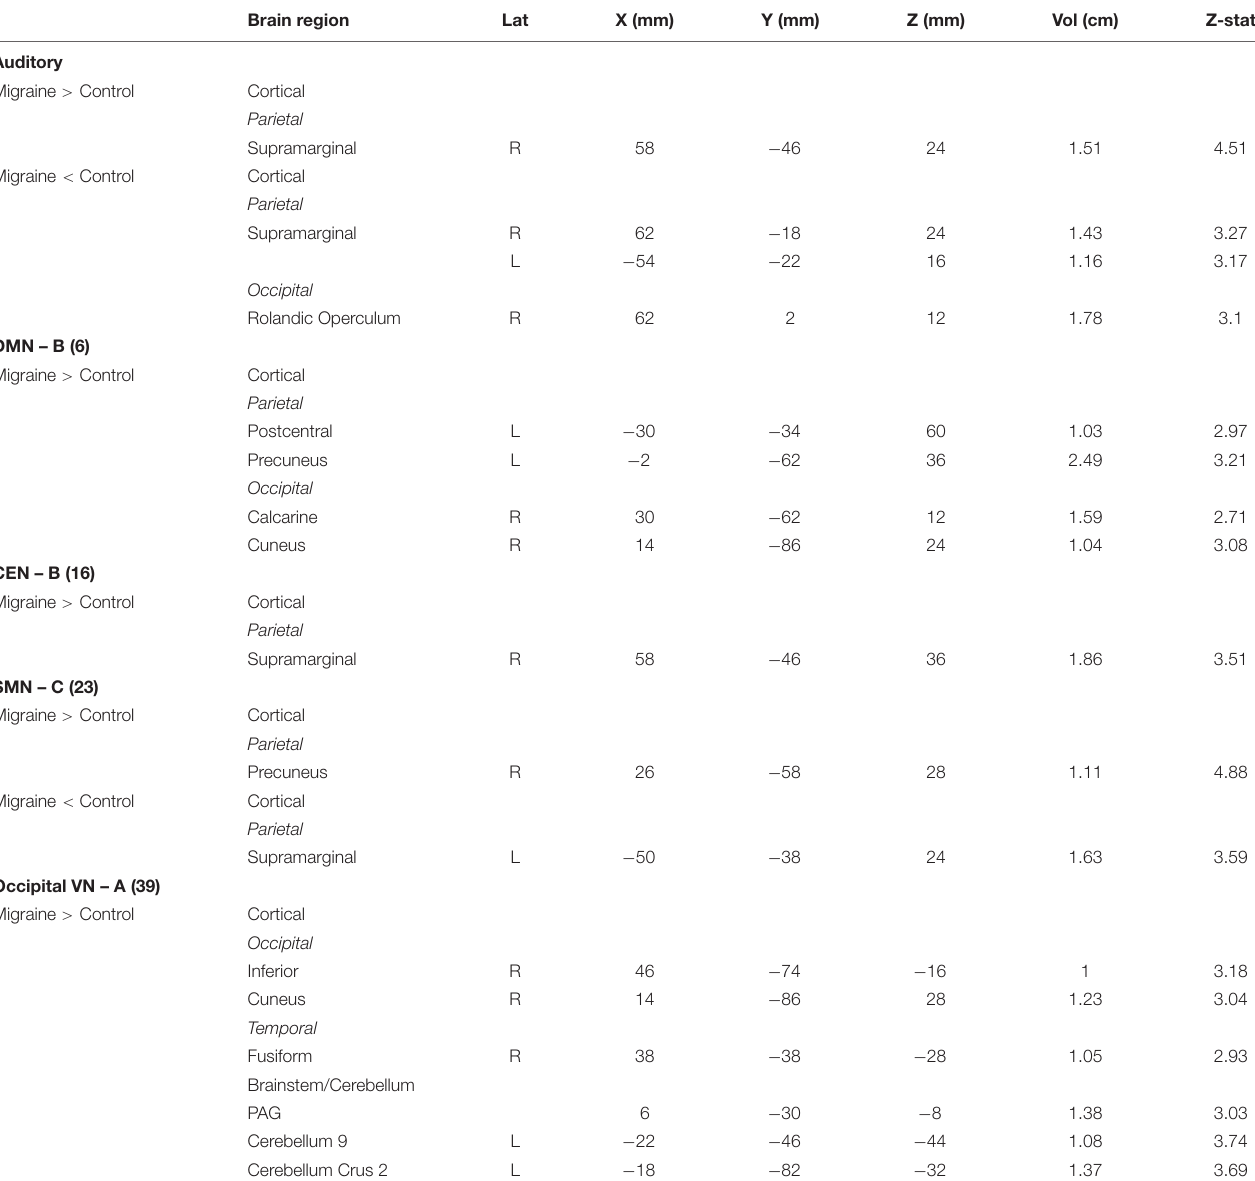
TABLE 5 | Disease effects in young adults.